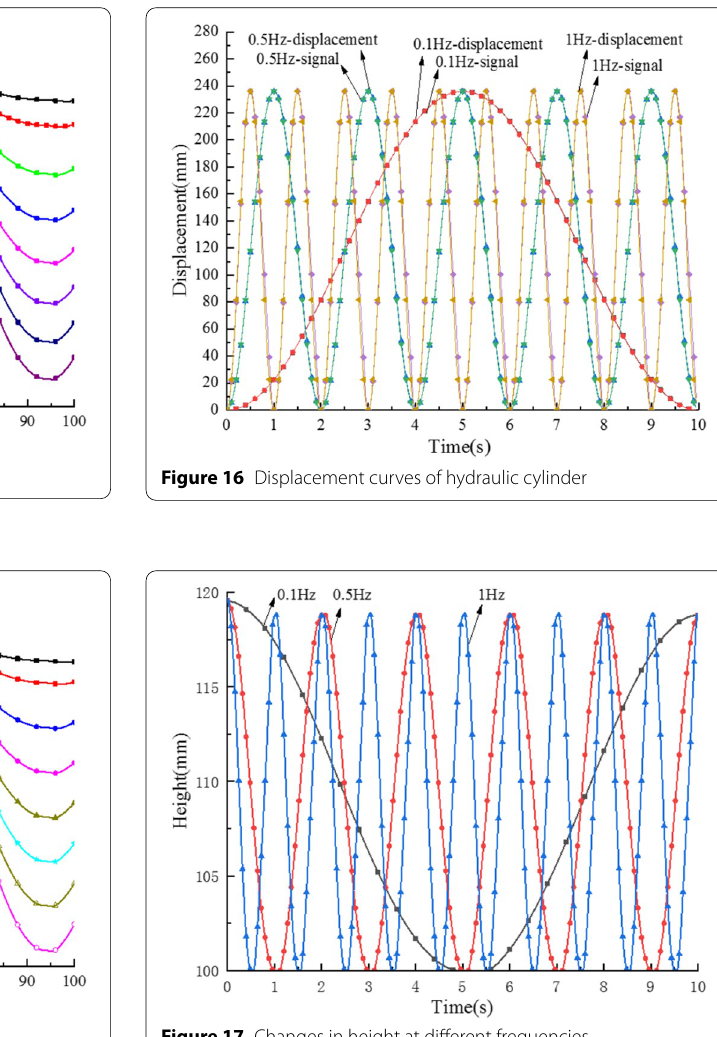
Figure 15 Changes in volume at different ratios